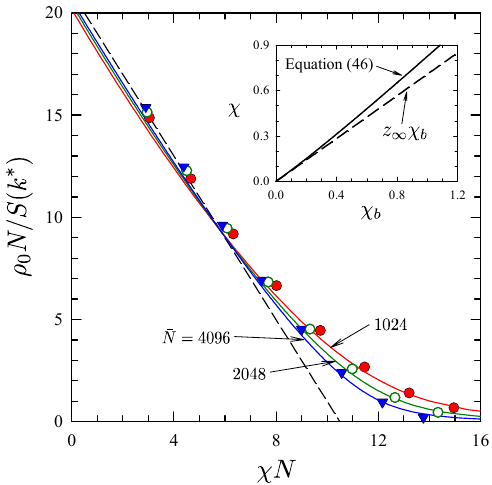
Figure 2. Inverse peak height of the structure function, S − 1 ( k ∗ ) , plotted in terms of effective χ for different invariant polymerization indices, ¯ N . Symbols denote FTS results, solid curves show the ROL predictions, and the dashed line is the RPA prediction. The linear and nonlinear χ in Equations (42) and (46) are plotted in the inset with dashed and solid lines, respectively. Reproduced from Ref.